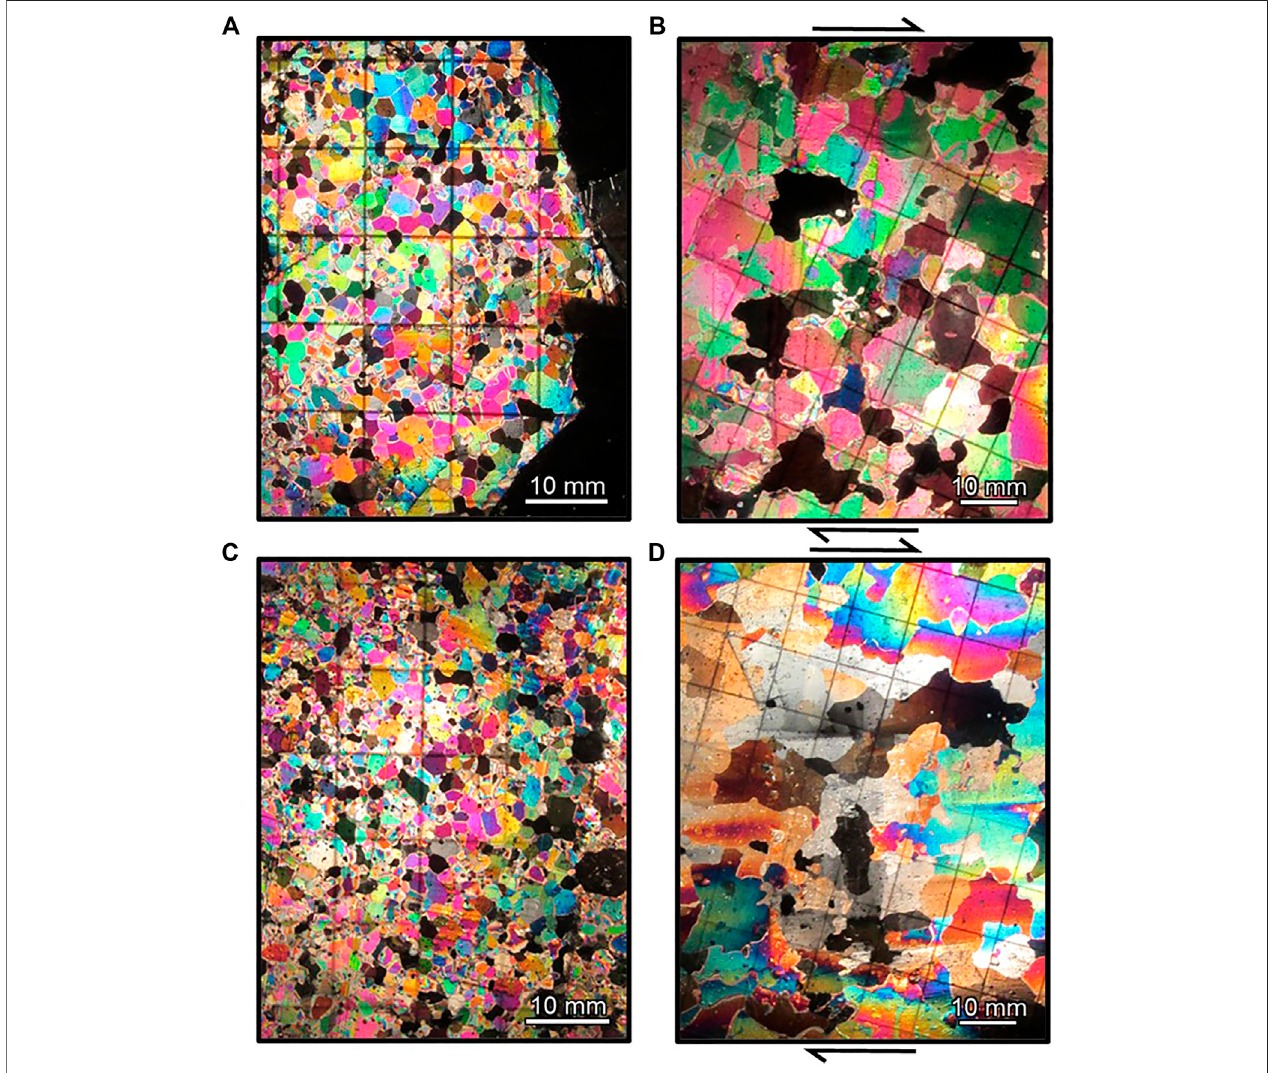
FIGURE 5 | Initial and fi nal ice textures (A,B) from Experiment 5 and (C,D) from Experiment 11 viewed under polarized light. Initial ice textures (A,C) are from the plane of shear; fi nal ice textures (B,D) are in a longitudinal fl ow plane. Grid squares are 10 mm × 10 mm. Arrows indicate the orientation of shear.